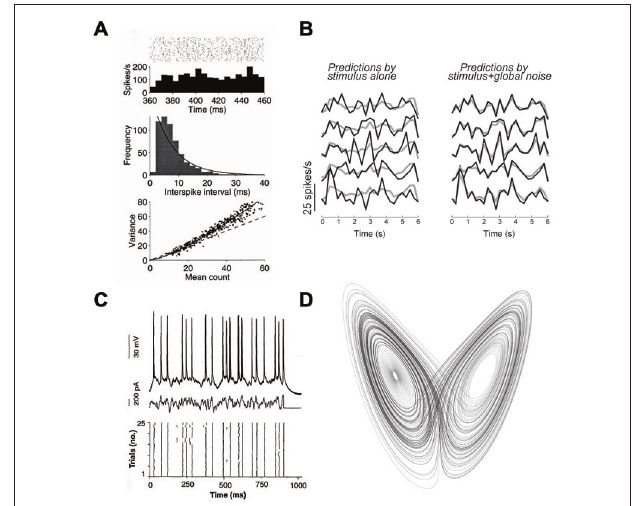
FIGURE 2 | Neural variability. (A) Responses of a MT neuron to the same stimulus (reproduced from Shadlen and Newsome, 1998). Top: spike trains over repeated trials, with the corresponding firing rate, meant as a firing probability ( Figure 1C ). Middle: distribution of Interspike intervals (ISIs), with an exponential fit (solid curve). Bottom: variance of spike count as a function of mean count, with the prediction for Poisson processes (dashed). (B) Responses of the same V1 neuron over five trials of the same stimulus, represented as temporal firing rate (adapted from Schölvinck et al., 2015). Left: comparison with the average response (gray curve), showing variability over trials. Right: comparison with a prediction using the responses of other neurons, showing that the variability does not reflect private noise. (C) Responses of a single cortical neuron to a fluctuating current (middle) injected in vitro (reproduced from Mainen and Sejnowski, 1995). Top: superimposed voltage traces. Bottom: spike trains produced in the 25 trials. (D) The Lorentz attractor, consisting of trajectories of a chaotic three-dimensional climate model. Chaos is not randomness, as it implies particular relations between the variables represented by the